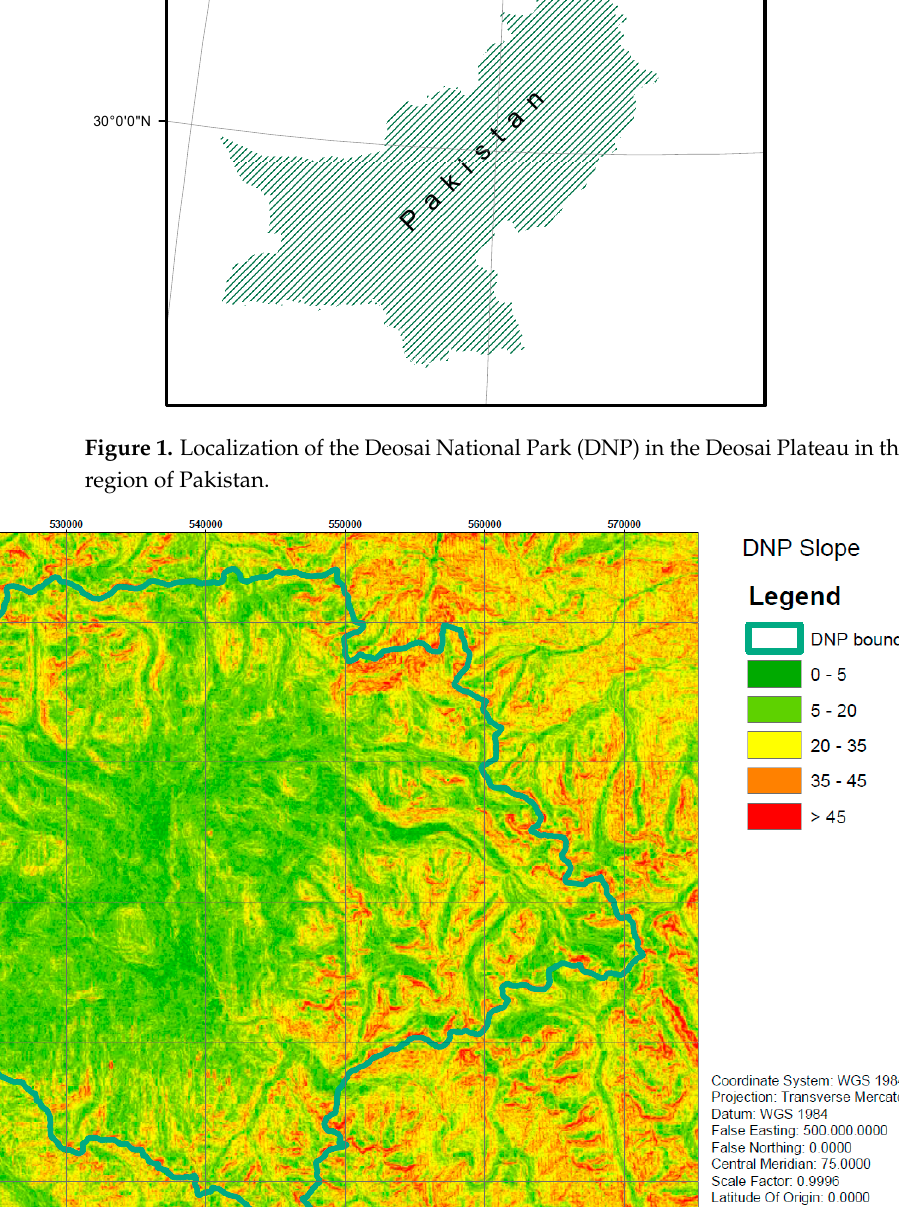
Figure 2. The slope map of the DNP (data are expressed in degrees).